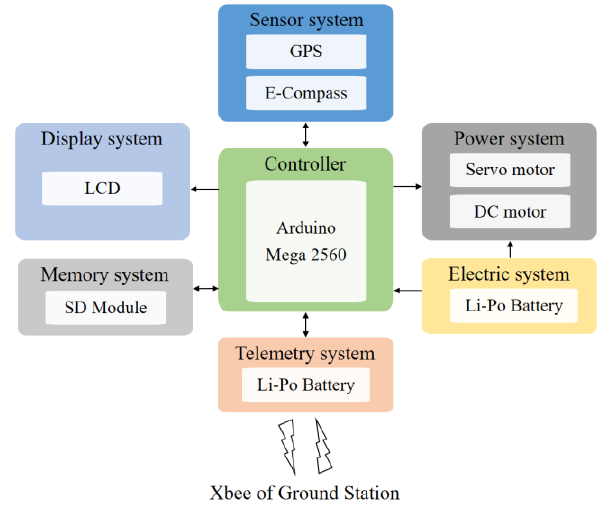
Figure 7. The Sub-System of Robot Car Architecture Diagram.